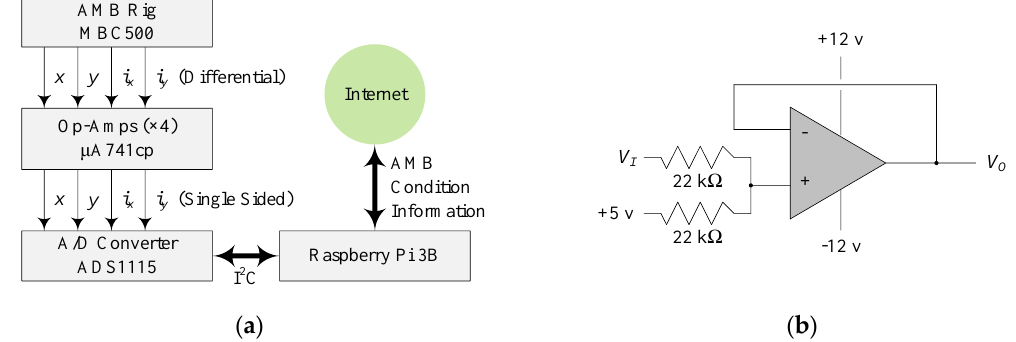
Figure 5. Hardware added for IoT implementation: ( a ) overall scheme; and ( b ) op-amp wiring